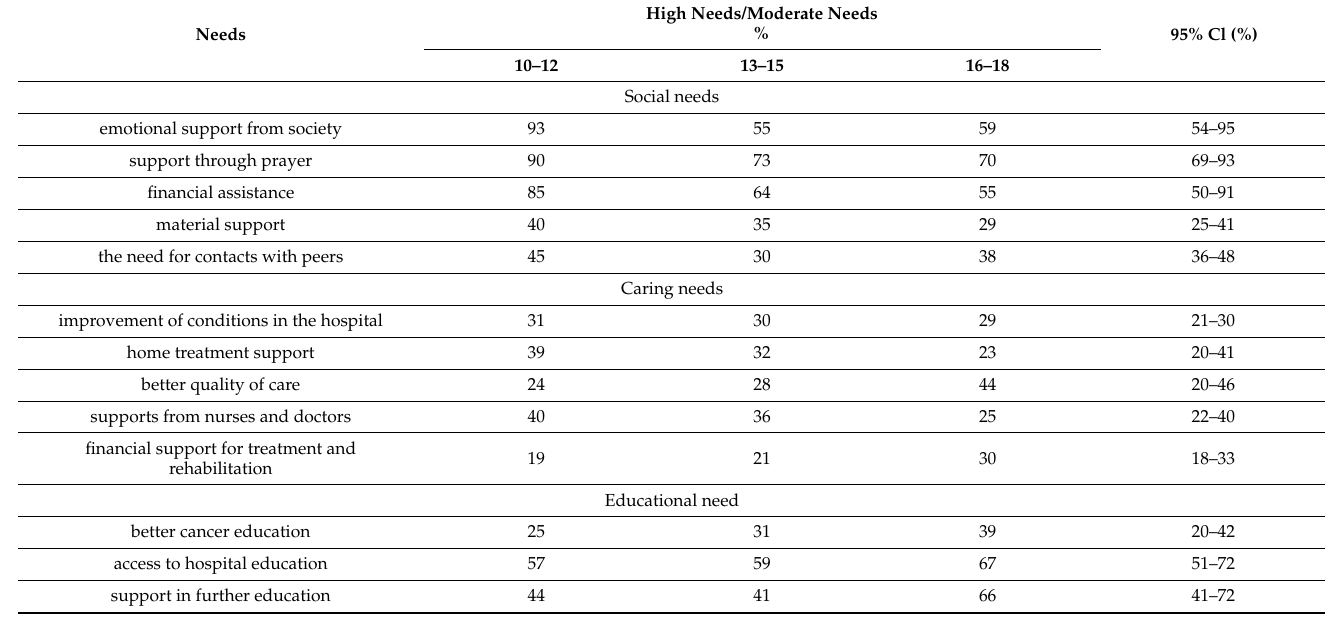
Table 6. Patients’